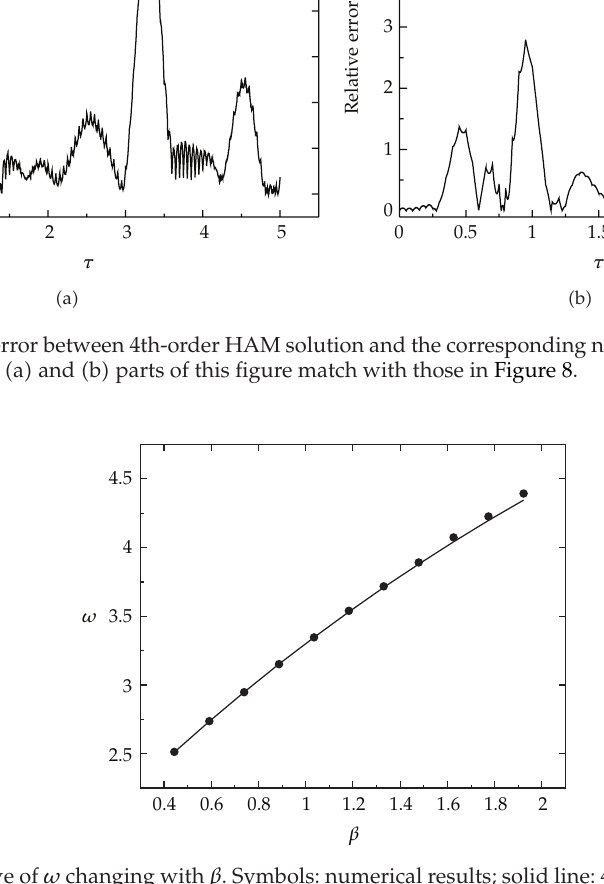
Figure 10: The curve of ω changing with β . Symbols: numerical results; solid line: 4th-order HAM approx-